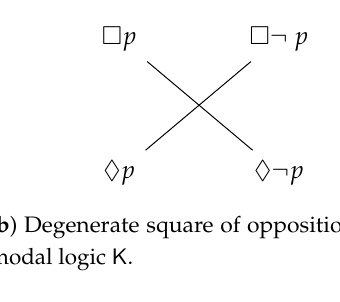
Figure 1. Aristotelian diagrams for { (cid:3) p , ♦ p , (cid:3) ¬ p , ♦ ¬ p } with respect to two systems of modal logic. Full, dashed, and dotted lines visualize contradiction, contrariety, and subcontrariety, respectively; arrows visualize